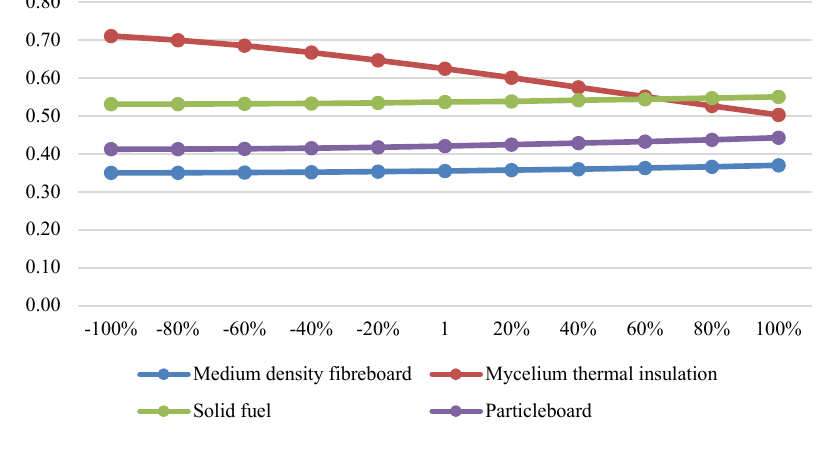
Fig. 6. Sensitivity analysis on mycelium thermal insulation’s production cost